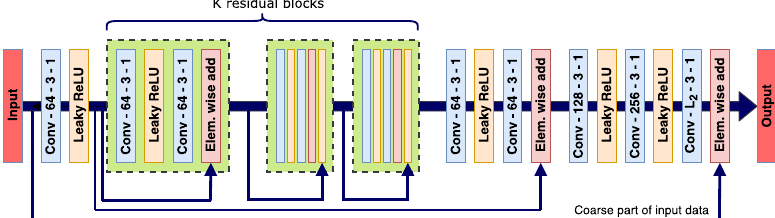
Figure 3. The structure of the residual network. Conv-64-3-1 denotes a conv layer with 64 filters of size 3 and stride